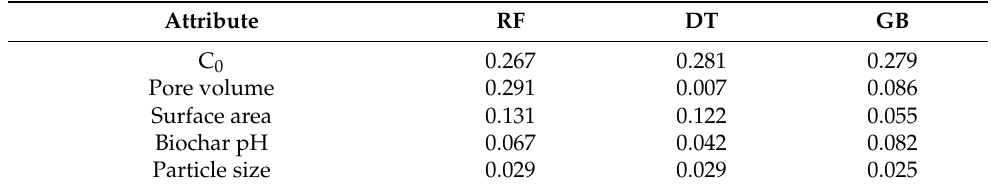
Table 2. Variable importance of the five selected variables based on the feature selection criteria.